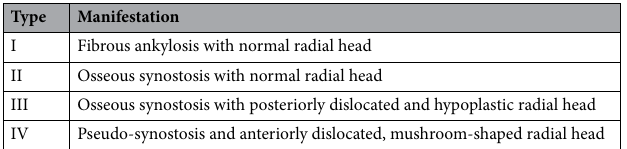
Table 1. Radiographic manifestation of cleary & omer